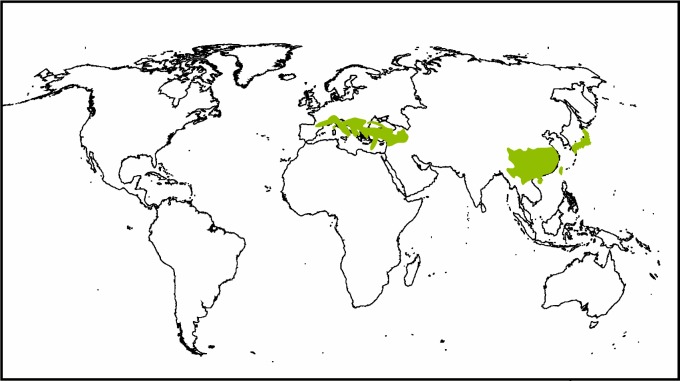
Geographic distribution of extant Paliurus [1, 4].